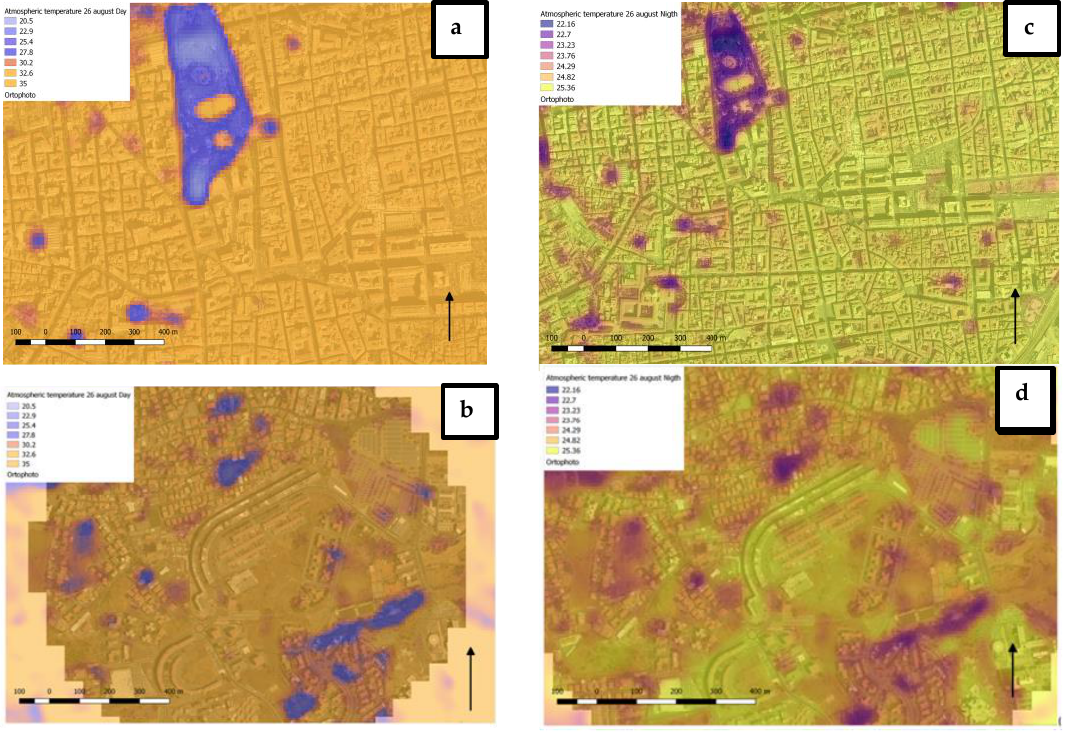
Figure 12. Daily atmospheric temperature in Stesicoro square ( a ) and San Nullo District ( b ), night atmospheric temperature in Stesicoro square ( c ) and San Nullo District ( d ).